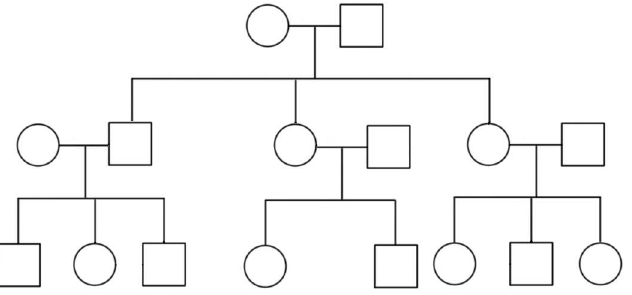
Fig 1. Three-Generation Pedigree Used in Simulations. In the simulations, each sampled family is assumed to have a 3-generation, 16-person pedigreeof this